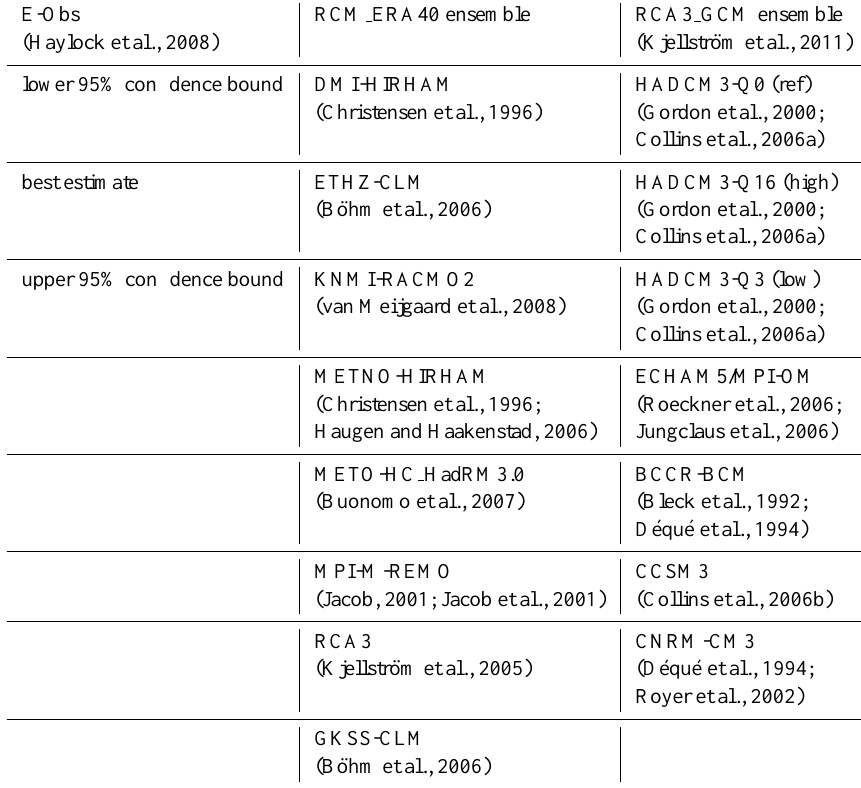
Table 2. List of climate data used in this study. For brevity, shorthand model names were used in the text and